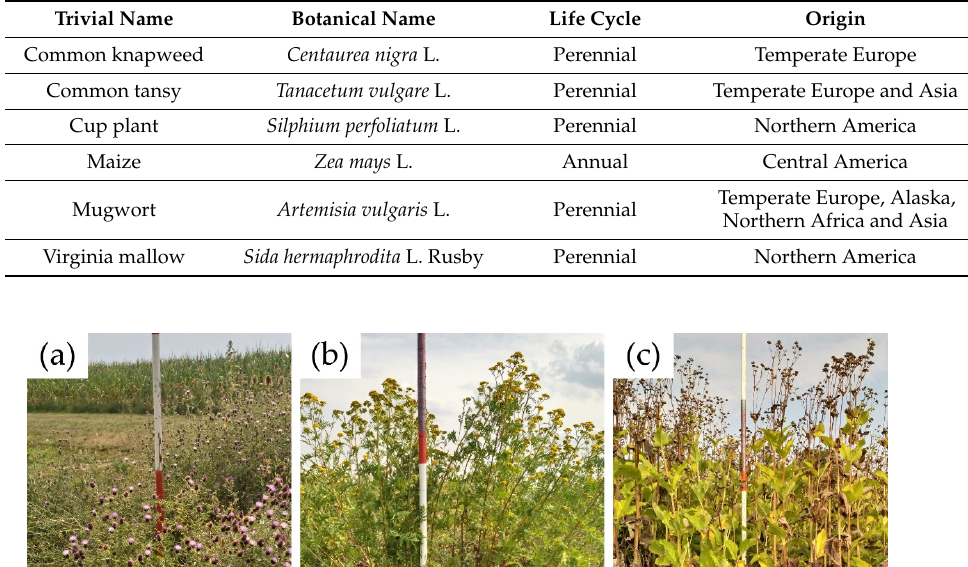
Table 1. Overview of the crops (sorted alphabetically) used in this study.